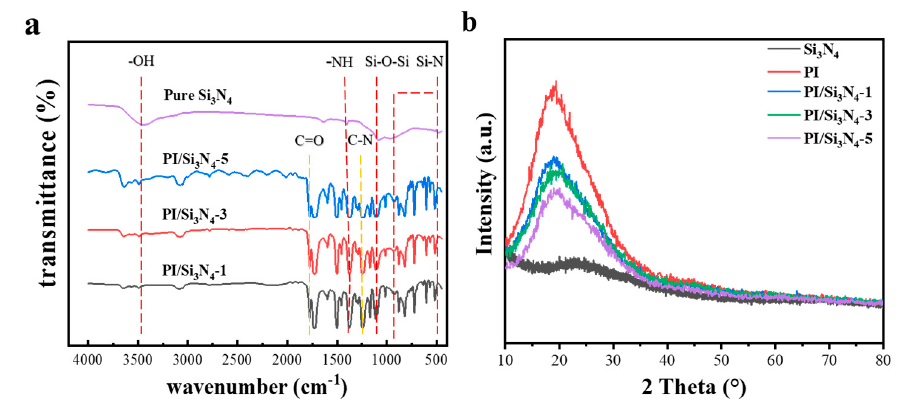
Figure 2. FTIR ( a ) and XRD ( b ) spectra of pure Si 3 N 4 nanoparticles and PI/Si 3 N 4 matrix.